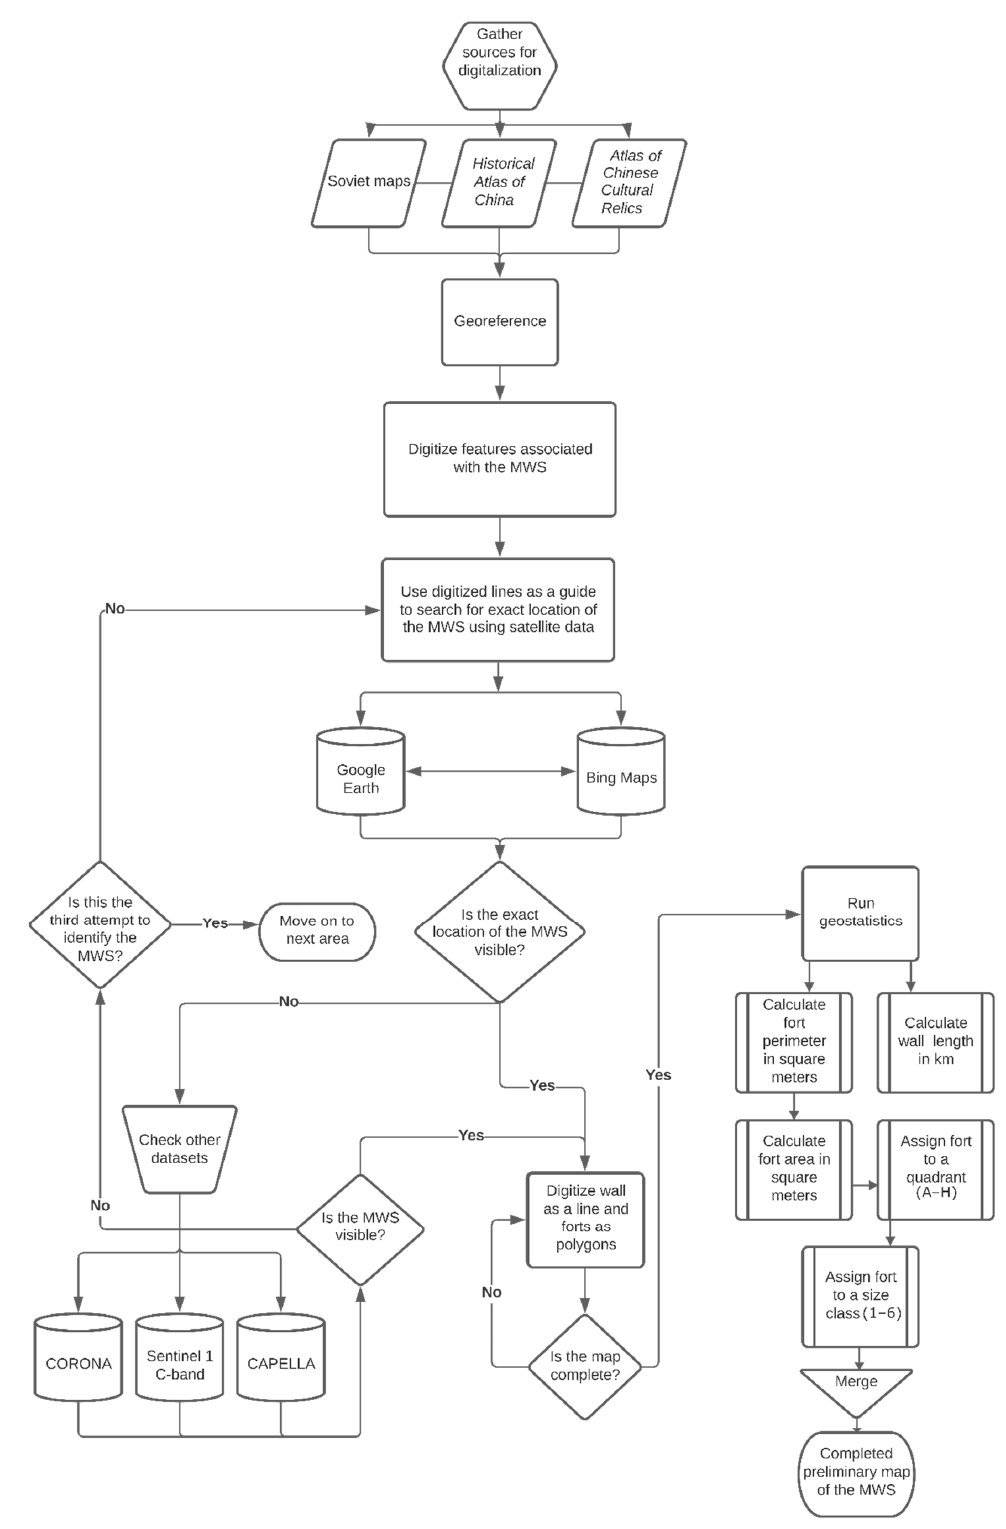
Figure 3. Workflow diagram of the multi-method approach used to precisely plot the location of the MWS.